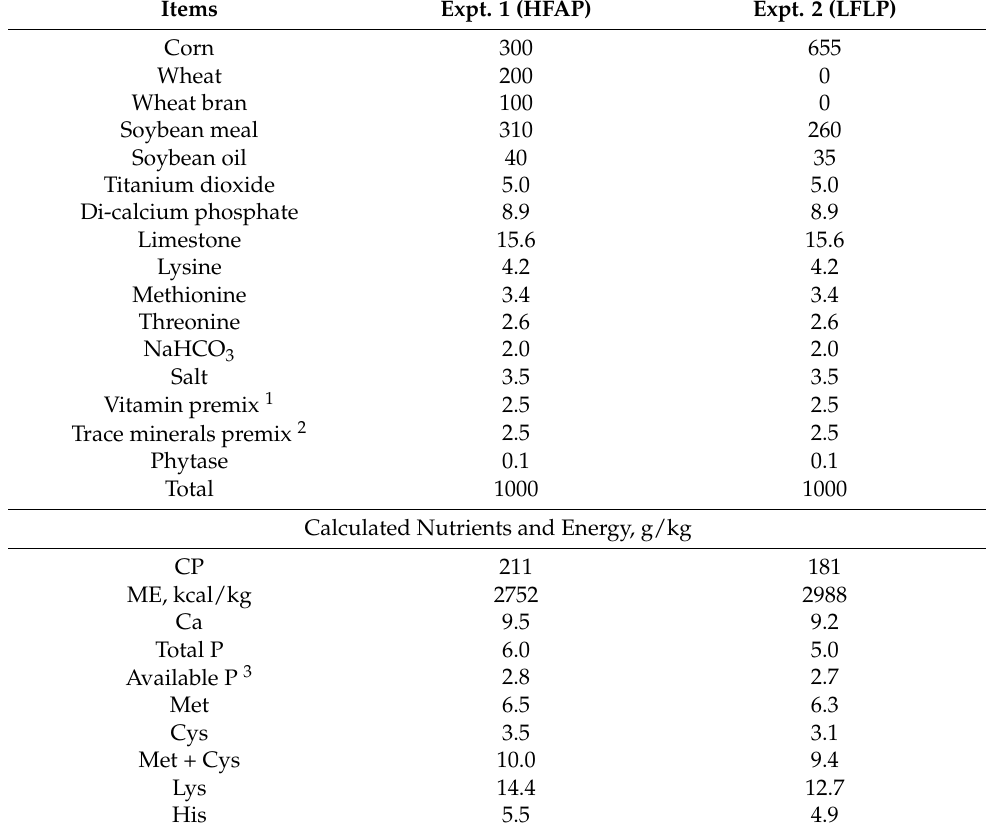
Table 2. The analyzed enzyme activities were, on average 311, 9500, and 18,700 units per kg for phytase, xylanase, and protease, respectively. The analyzed activities were 62%, 56%, and 124% of expected activities for phytase, xylanase, and protease, respectively. Table 1. Ingredient compositions (g/kg) of the experimental basal diets. Items Expt. 1